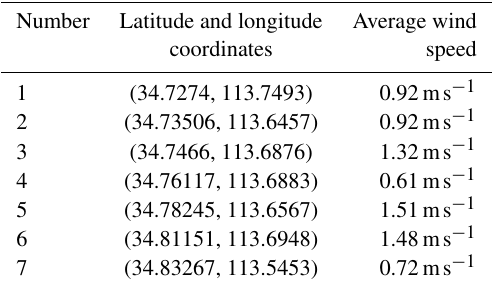
Table A2. The location of each meteorological station and the av- erage wind speed.